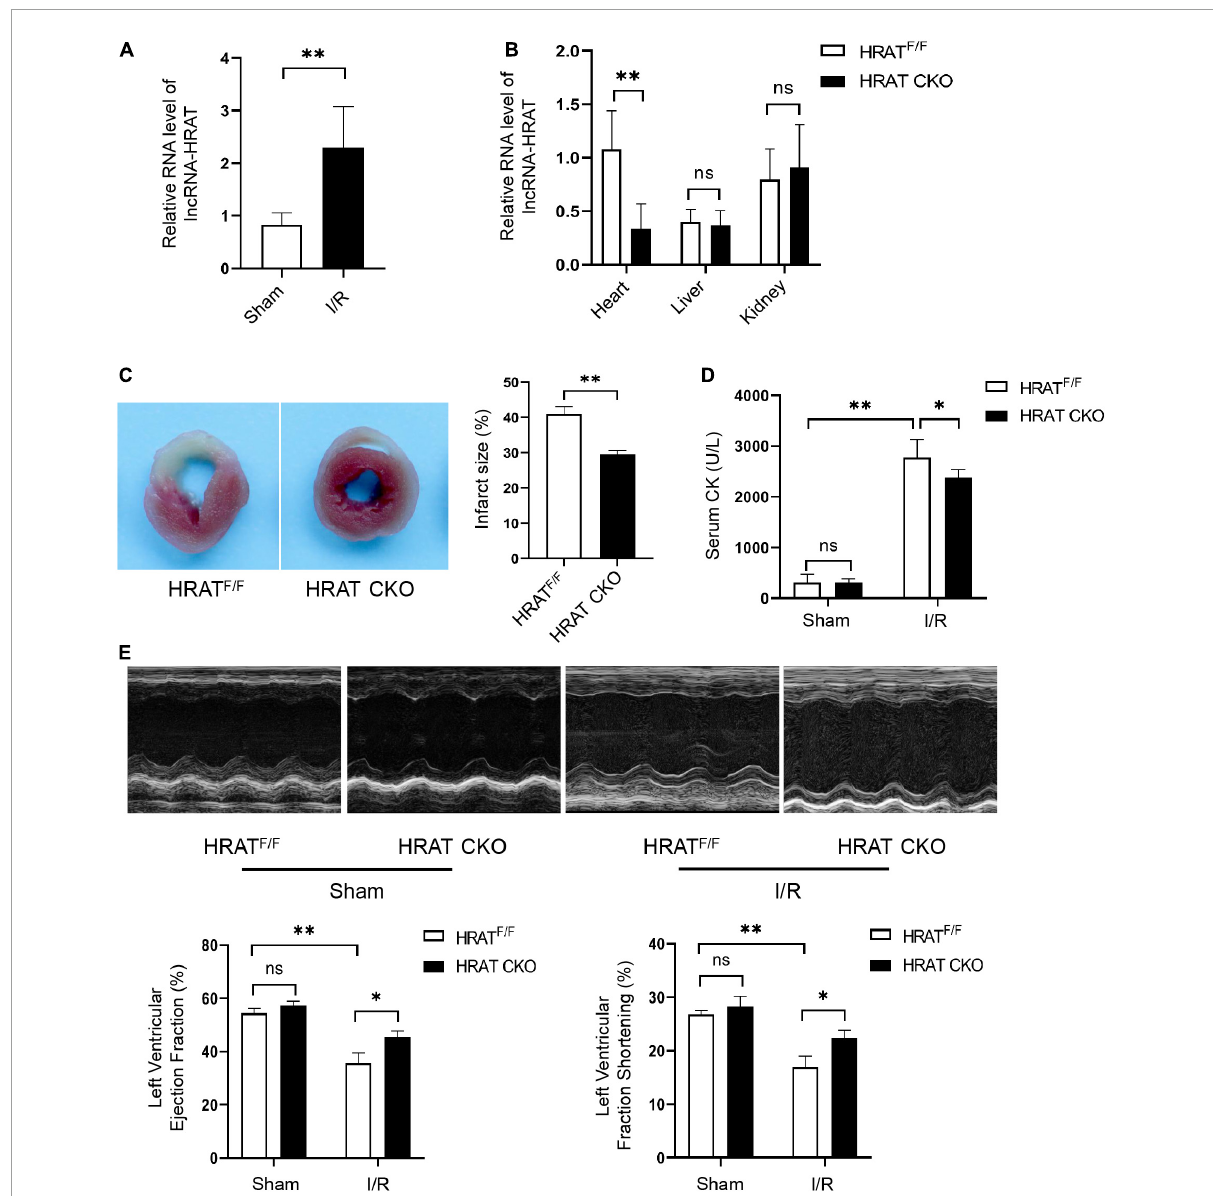
FIGURE4 Cardiomyocyte-specific deficiency of lncRNA-HRAT protects mice hearts against I/R injury. (A) LncRNA-HRAT expression in I/R (45’/3 hr) and sham mice hearts was analyzed through qRT-PCR ( n = 5). (B) Heart, liver, kindey were prepared from control HRAT floxed (HRAT F / F ) and HRAT CKO mice and subjected to qRT-PCR ( n = 5). (C) The infarct size of the hearts in HRAT F / F and HRAT CKO mice subjected to I/R (45’/24 hr) was measured by TTC staining ( n = 5). (D) Circulating levels of creatine kinase (CK) in HRAT F / F and HRAT CKO mice after I/R (45’/3 hr) ( n = 5). (E) Representative echocardiograms (upper) and quantitative analysis of LVEF (%) (lower left) and LVFS (%) (lower right) in diverse groups of mice at day 7 ( n = 5). All the data are described as the mean ± SD. * P < 0.05, ** P < 0.01, ns = not